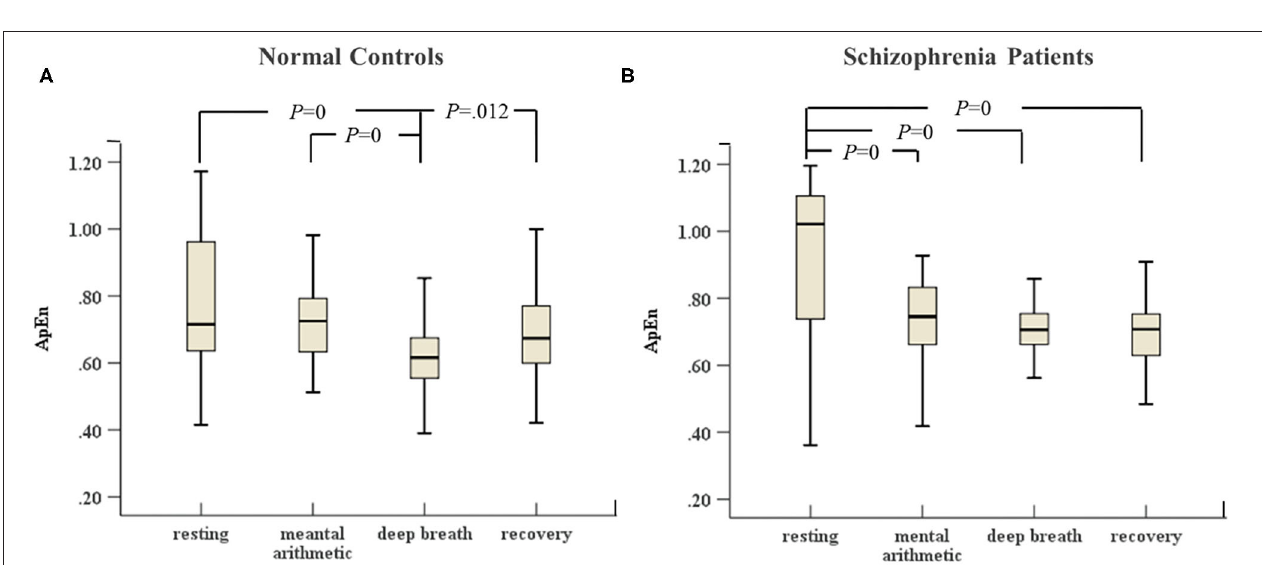
FIGURE 4 | (A) ApEn of HRV of normal controls ( n = 45) and (B) ApEn of HRV of schizophrenia patients ( n = 45) during the ANS test, which was analyzed with ANOVA, p < 0.05.